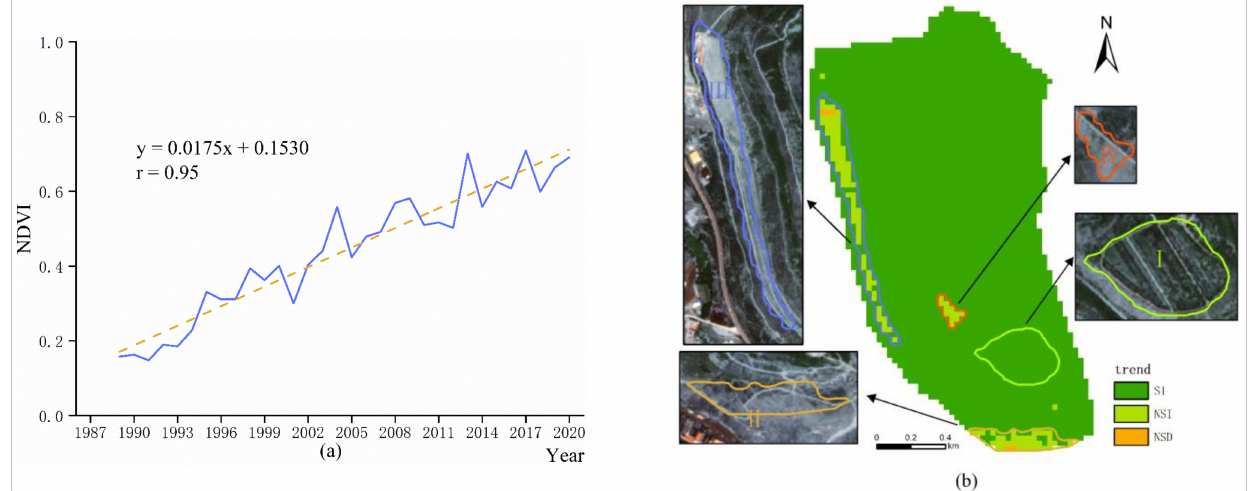
Figure 5. The time series analysis for NDVI on time and spatial scales in the west dump. ( a ) shows the results of the unary regression analysis. And ( b ) shows the results of the Sen+MK trend analysis. SI, NSI, NSD, and SD are, respectively, the abbreviations for significantly increase, not significantly increase, not significantly decrease, and significantly